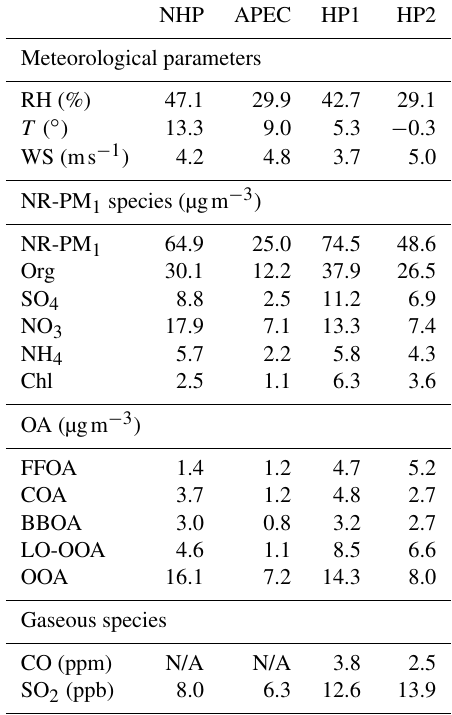
Table 1. Summary of the average meteorological parameters, NR- PM 1 species, OA factors, and gaseous species during four different periods (i.e., NHP, APEC, HP1, and